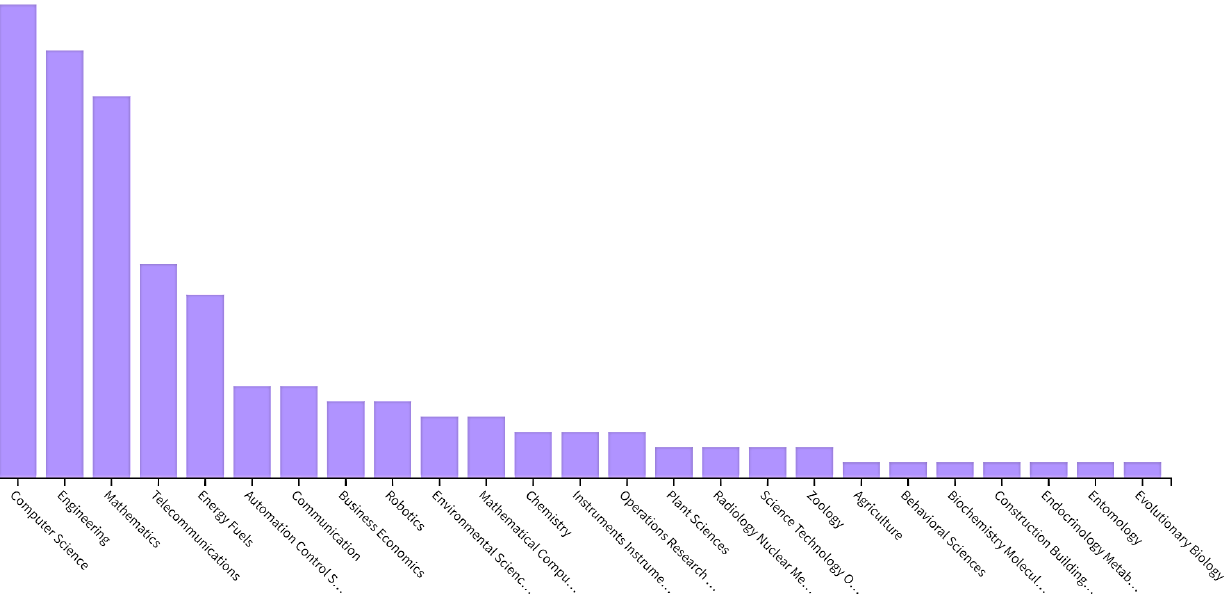
Figure 2. Related MS publications since 2018. MS optimization was systematically summarized and studied in this paper. From the various papers collected, 56 representative papers from 1 January 2018 to 23 August 2022 were selected and used for our survey. The classification proportions of MS opti- mization were showed in Figure 3. Table 1 showed that this paper divides the MS opti-